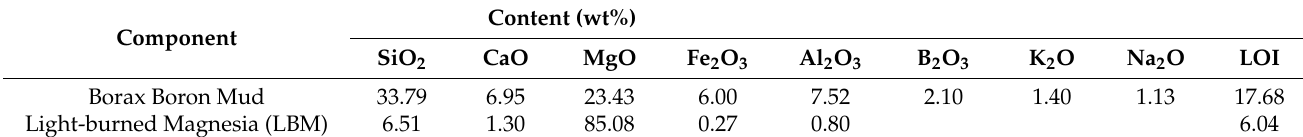
Table 1. Chemical compositions of light-burned magnesia (LBM) and Boron mud.